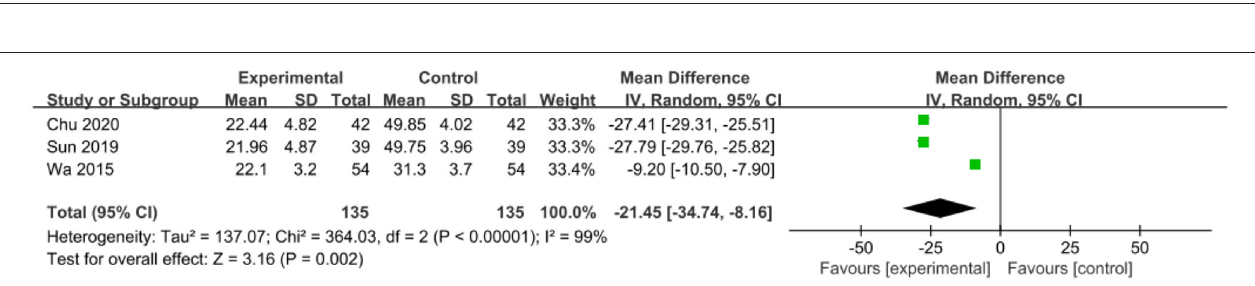
Frontiers in Nutrition |